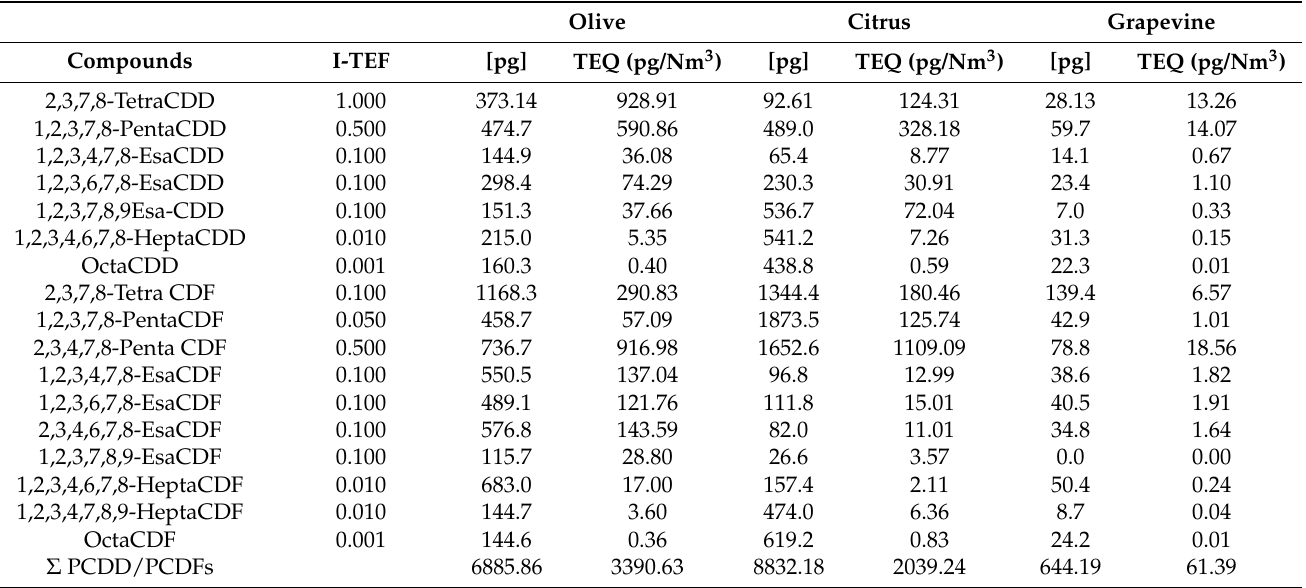
Table 8. PCDD/F amounts in pg and concentrations in Toxicity Equivalent (TEQ ng/Nm 3 ) of Olive, Citrus and Grapevine